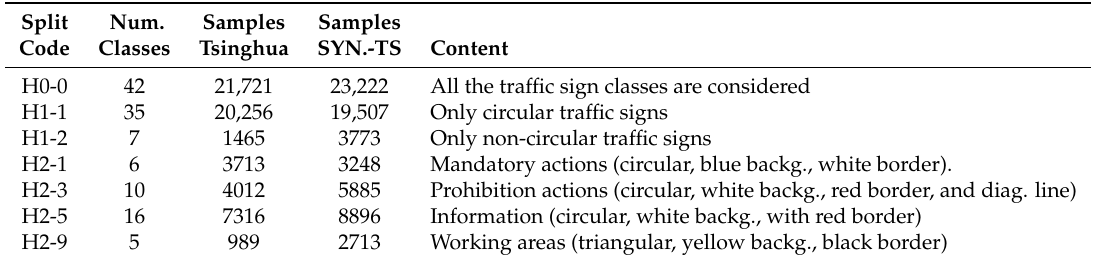
Table 2. Splits of Figure 3 used in appearance-driven experiments. Tsinghua samples are divided